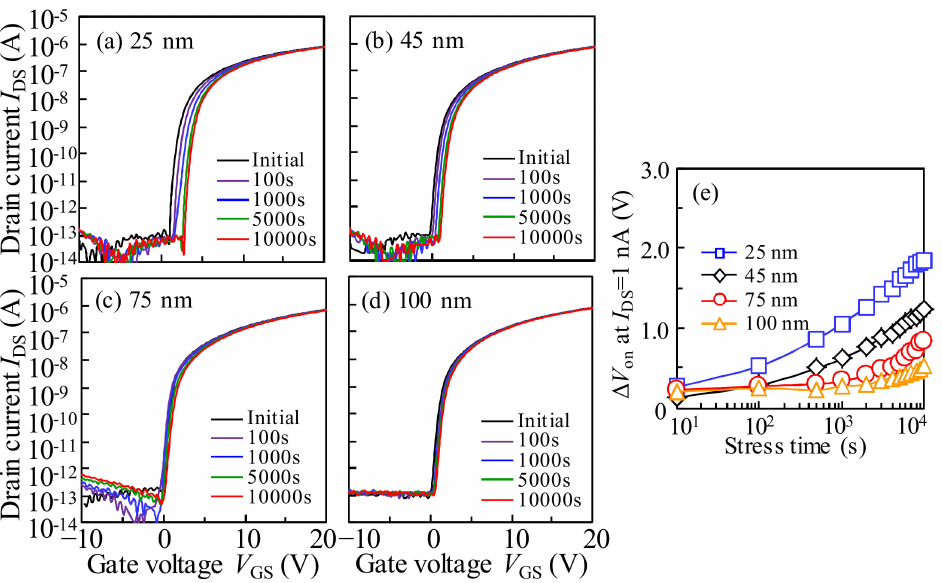
Figure 6. Evolution of transfer characteristics in the a-IGZO TFT with the T IGZO values of ( a ) 25 nm; ( b ) 45 nm; ( c ) 75 nm; and ( d ) 100 nm as a function of the 20 V positive gate bias stress (PBS) duration for 10 4 s; and ( e ) the variation in ∆ V on as a function of PBS duration for the a-IGZO TFTs with various T IGZO